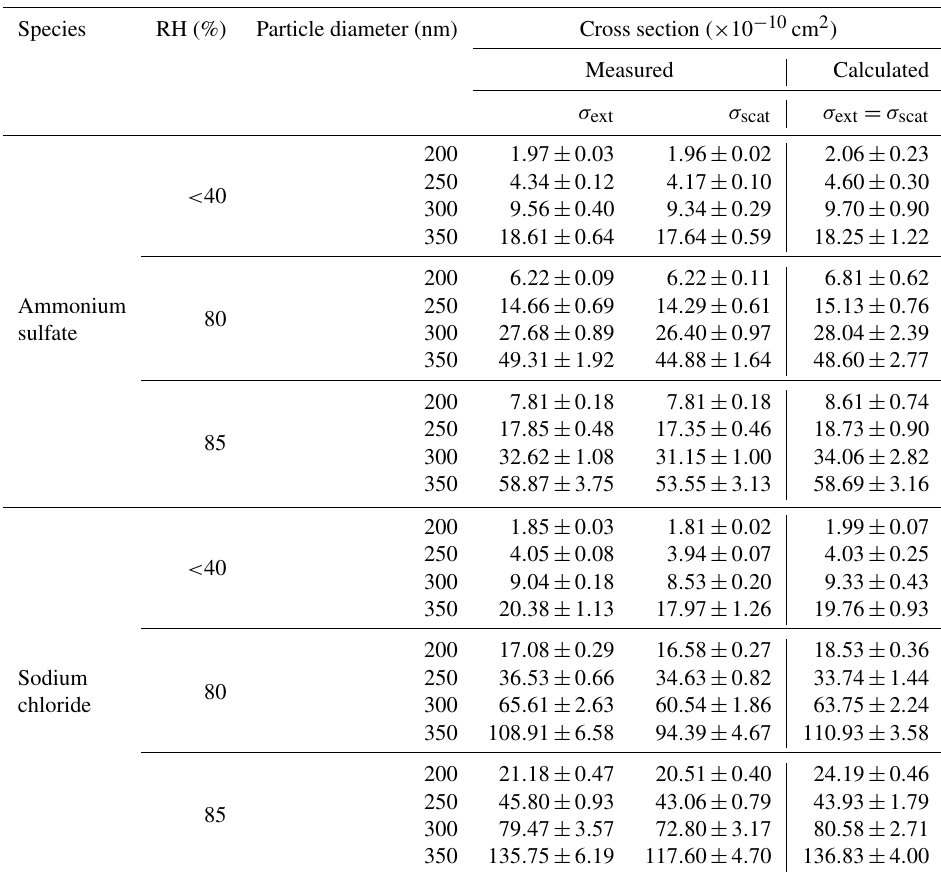
Table 2. Comparison between the measured and E-AIM-calculated extinction and scattering cross sections for the size-selected ammonium sulfate and sodium chloride particles under three selected RH